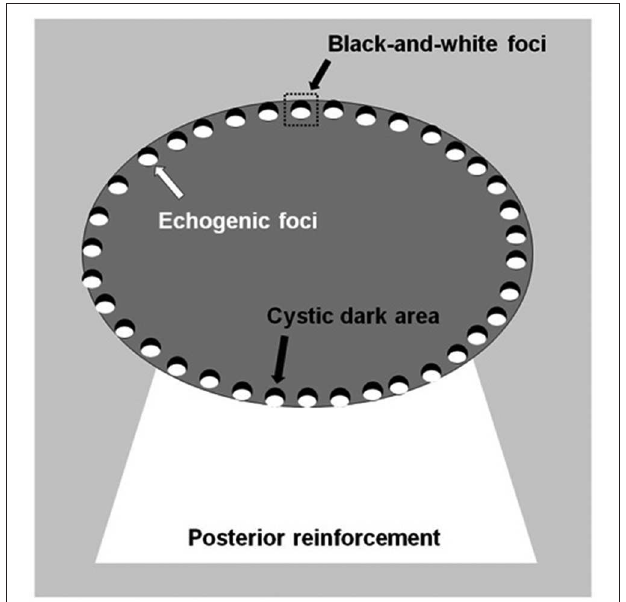
FIGURE 1 | Diagram shows sonographic assessment of a petal-like calcification in thyroid